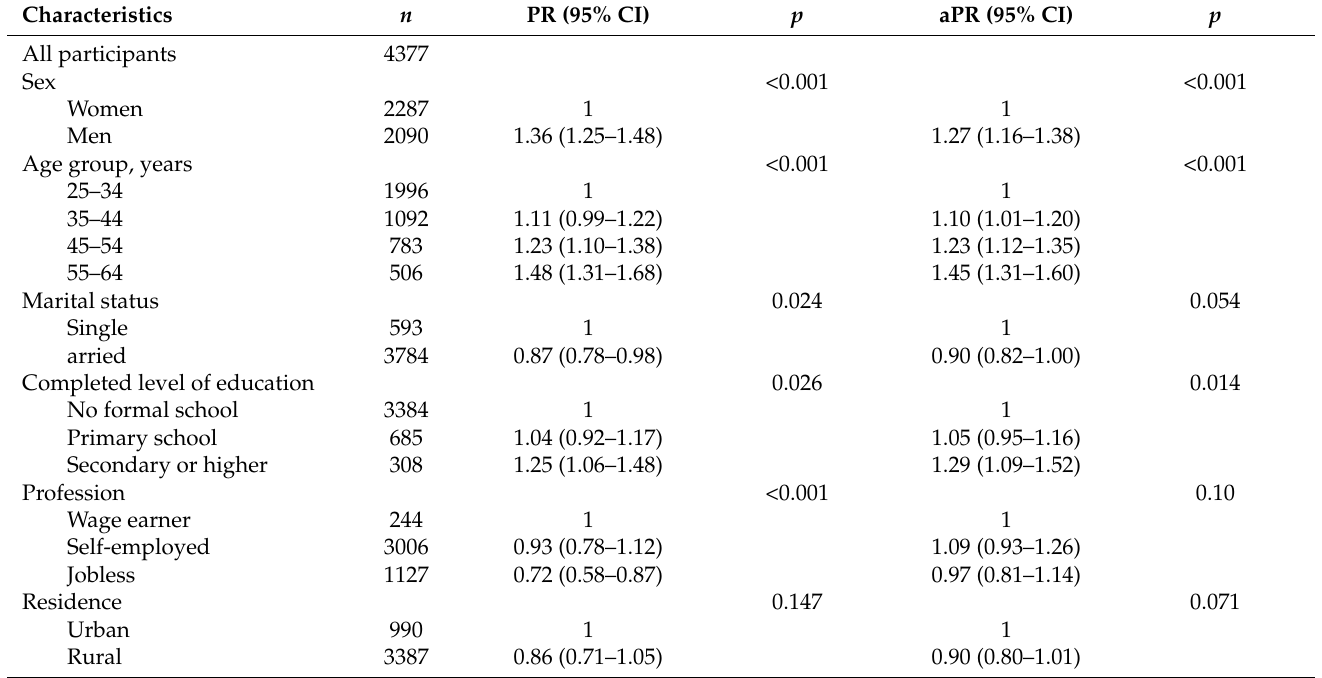
Table 3. Factors associated with the co-occurrence of lifestyle risk factors using a modified Poisson regression with generalized estimating